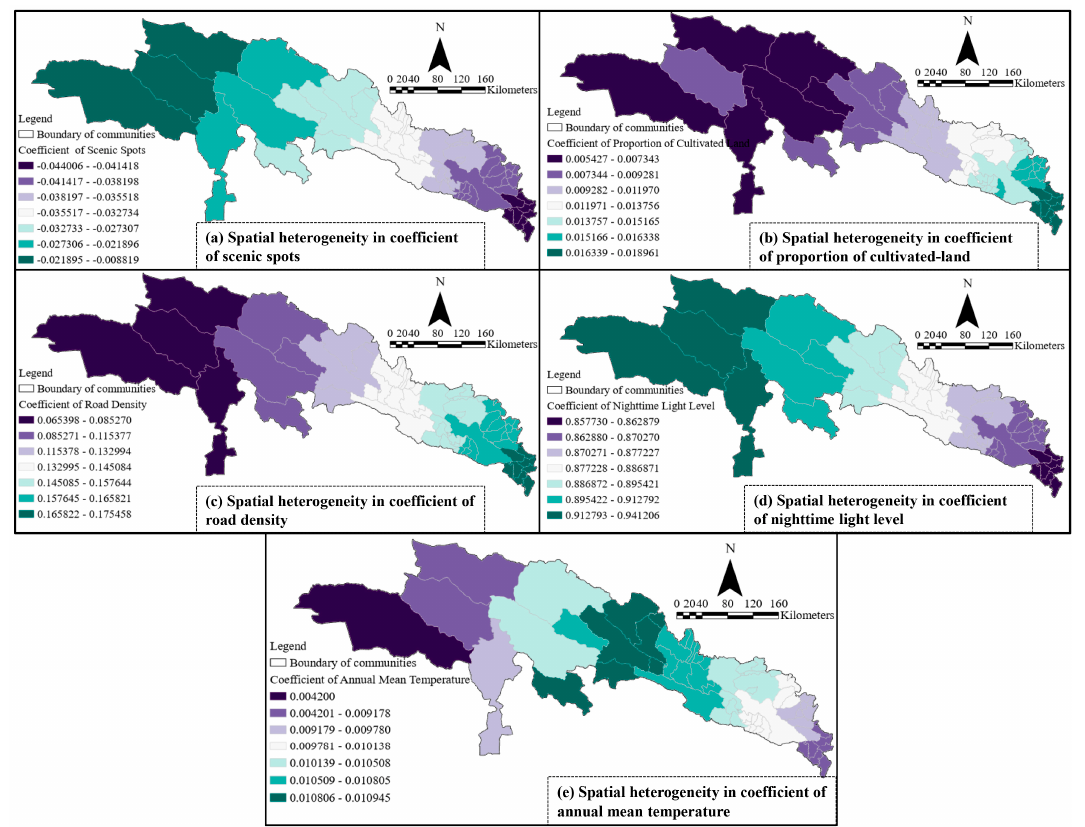
Figure 10. The spatial heterogeneity in the coefficients of the road density, nighttime light level, and average annual temperature with the SPLIT as the dependent variable.